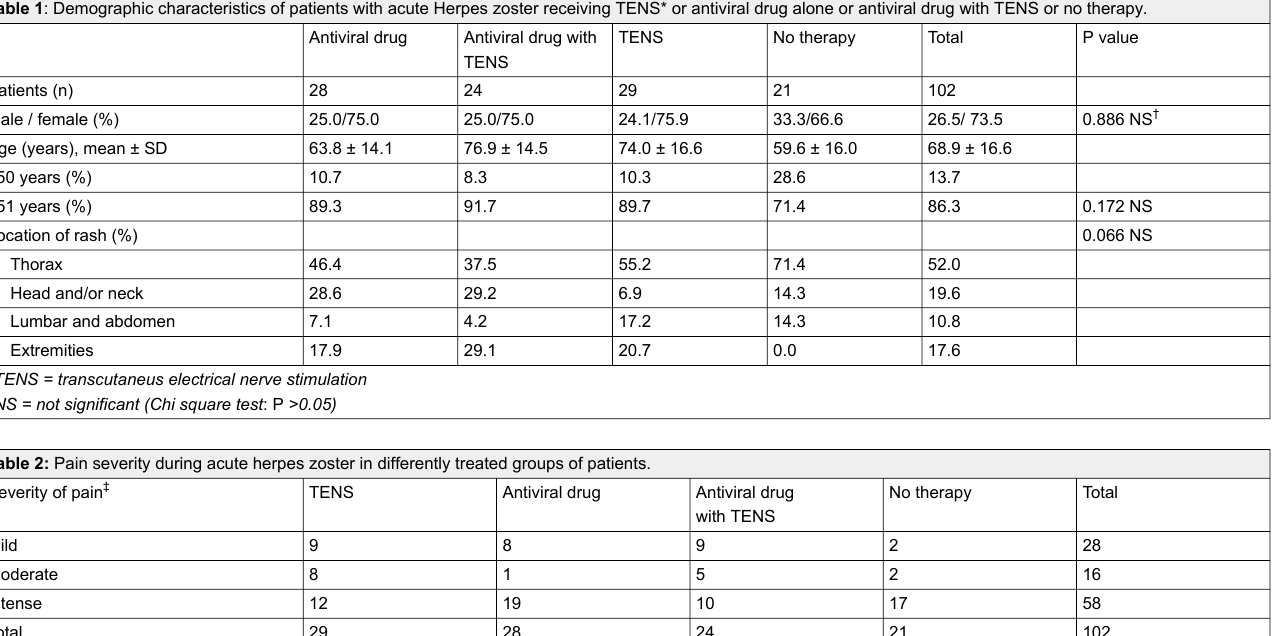
nonsteroid anti-inflammatory drug or/and tramadol